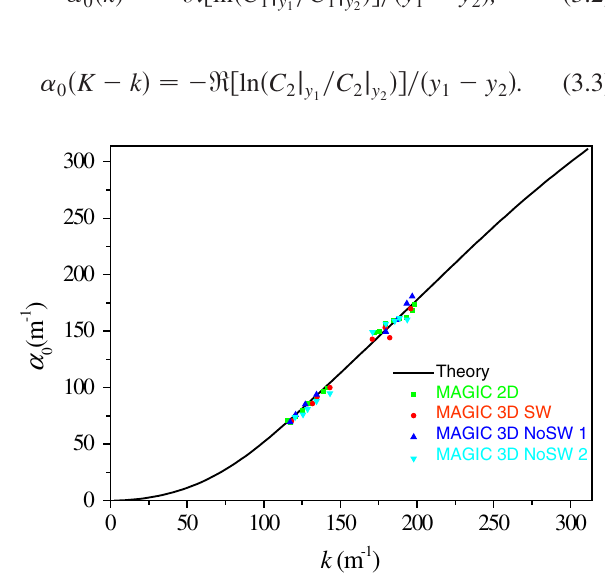
FIG. 11. The coefficient (cid:7) 0 [see Eq. (2.5)] for the lowest Floquet component as a function of wave number. According to theory, shown in black, (cid:7) 0 depends only on the wave number, and not on the frequency. Simulations in two and three dimen- sions, with and without sidewalls, were used to generate the points indicated, which tend to lie near the theoretical